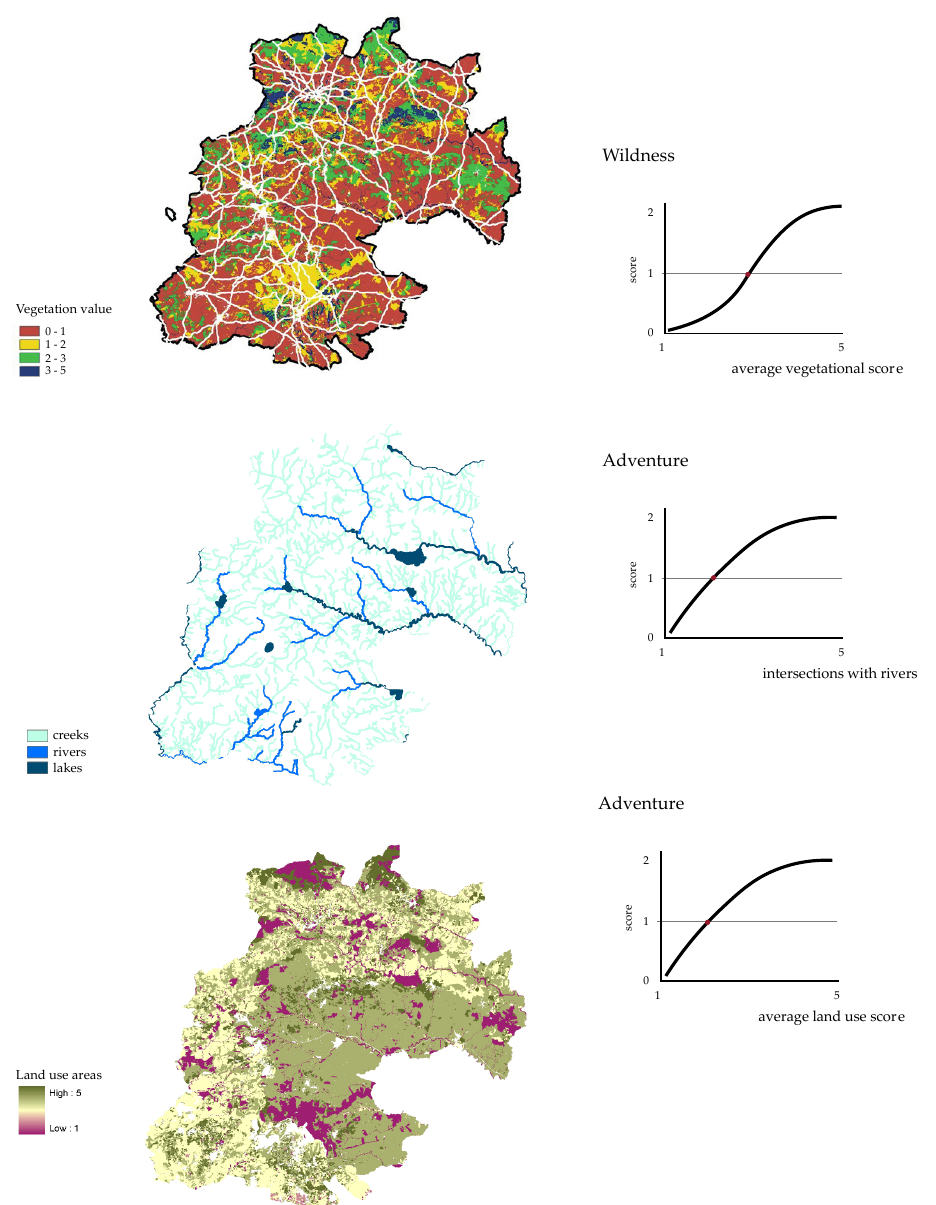
Figure 12. Utopian values. Mapping and value functions.